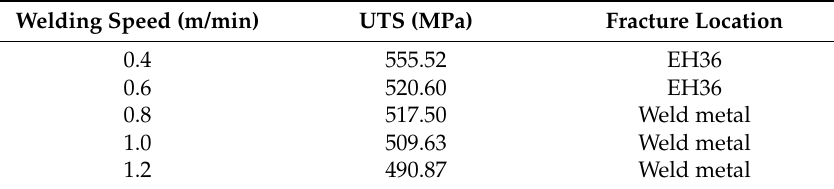
Figure 10. The stress-strain curves of the welds at different welding speeds. Table 3. Tensile strength of dissimilar metal laser welding samples.